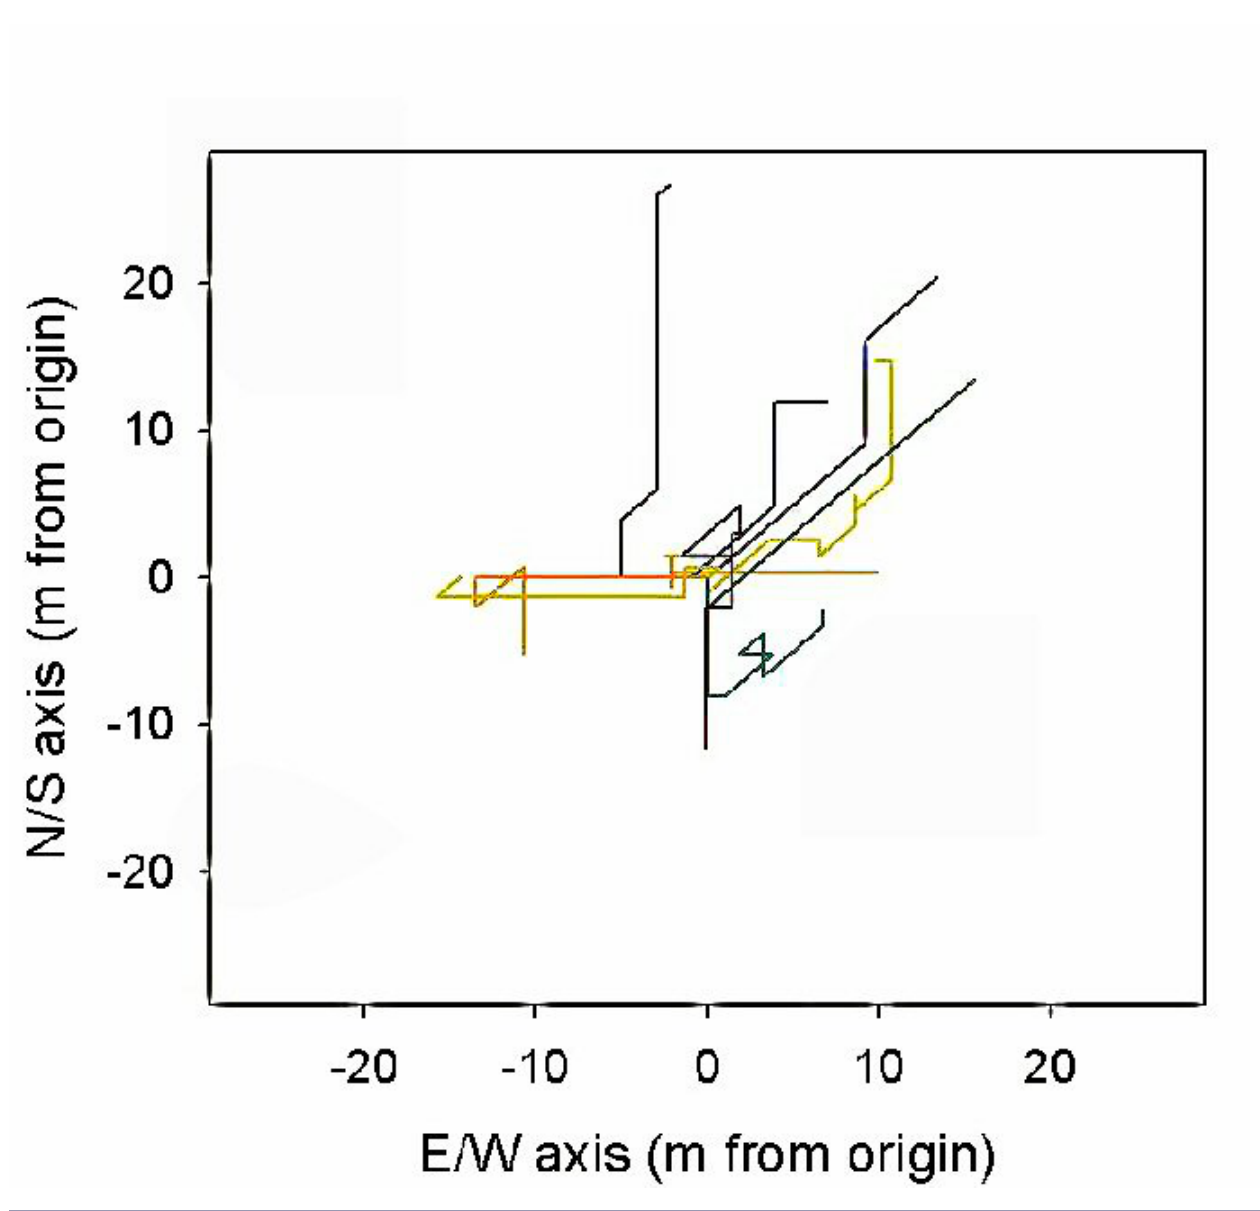
Fig. 1 . Tracks of extensive egg movement at 10 selected nests in 2003. Each color indicates the path of an individual egg. Origin of graph (0,0) indicates laying location of each